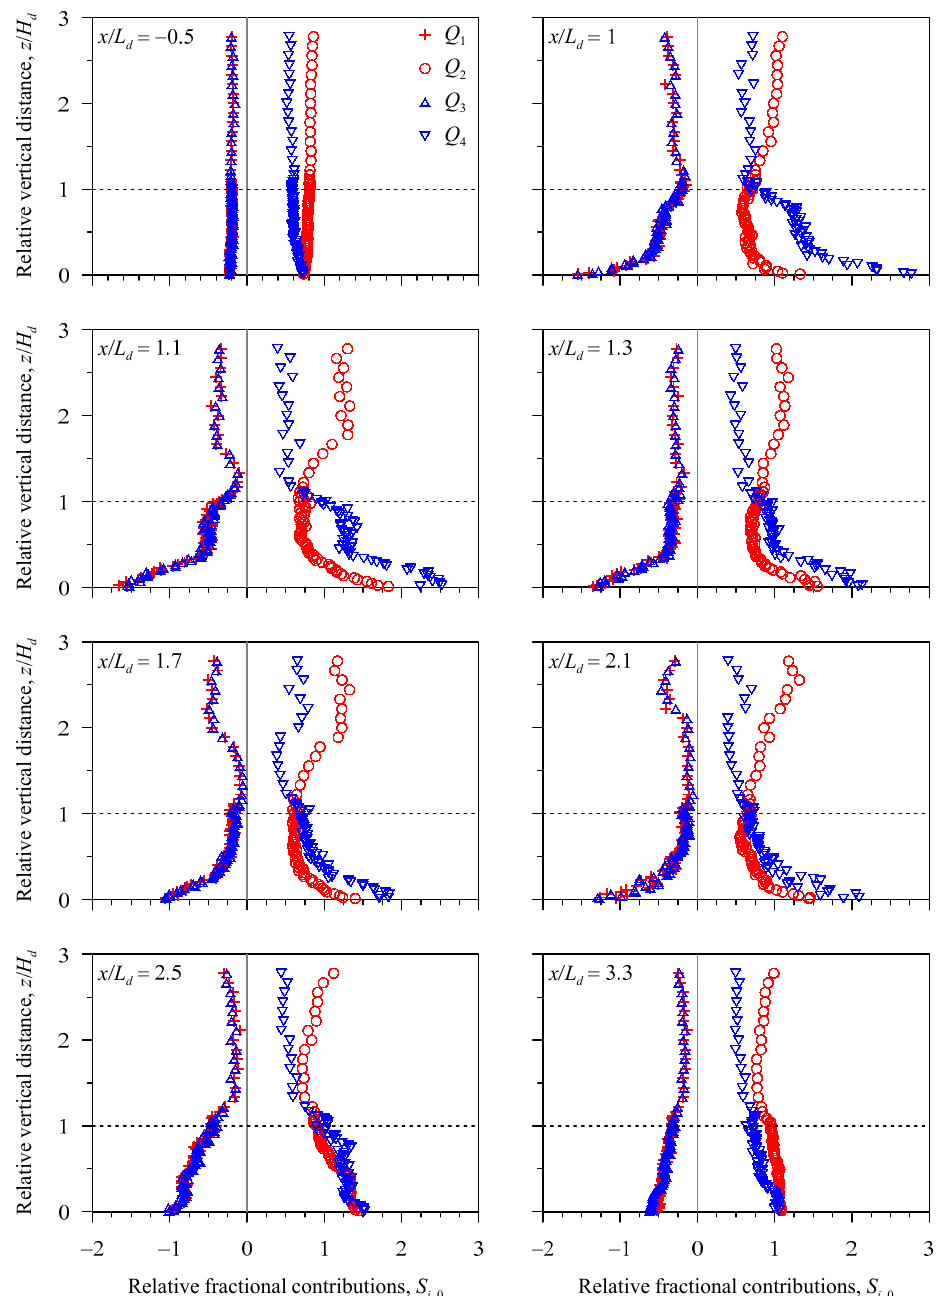
Figure 9. Vertical profiles of relative fractional contributions S i ,0 at various relative streamwise distances x / L d in Run 1.